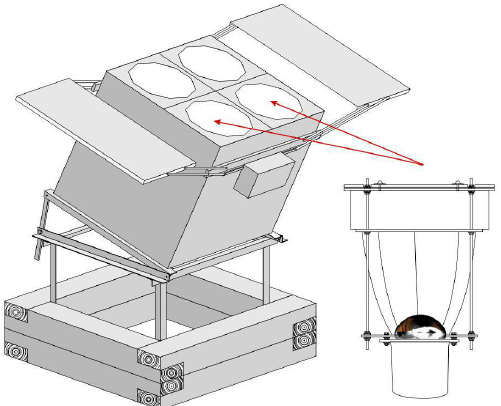
Figure 2: Schematical view of a Tunka-HiSCORE de- tector station. The tilting mechanism will allow to ac- cess a larger fraction of the sky as compared to observa- tions pointing at the zenith alone. Detail (right): Each of the four optical channels consists of a PMT with a light concentrator (Winston